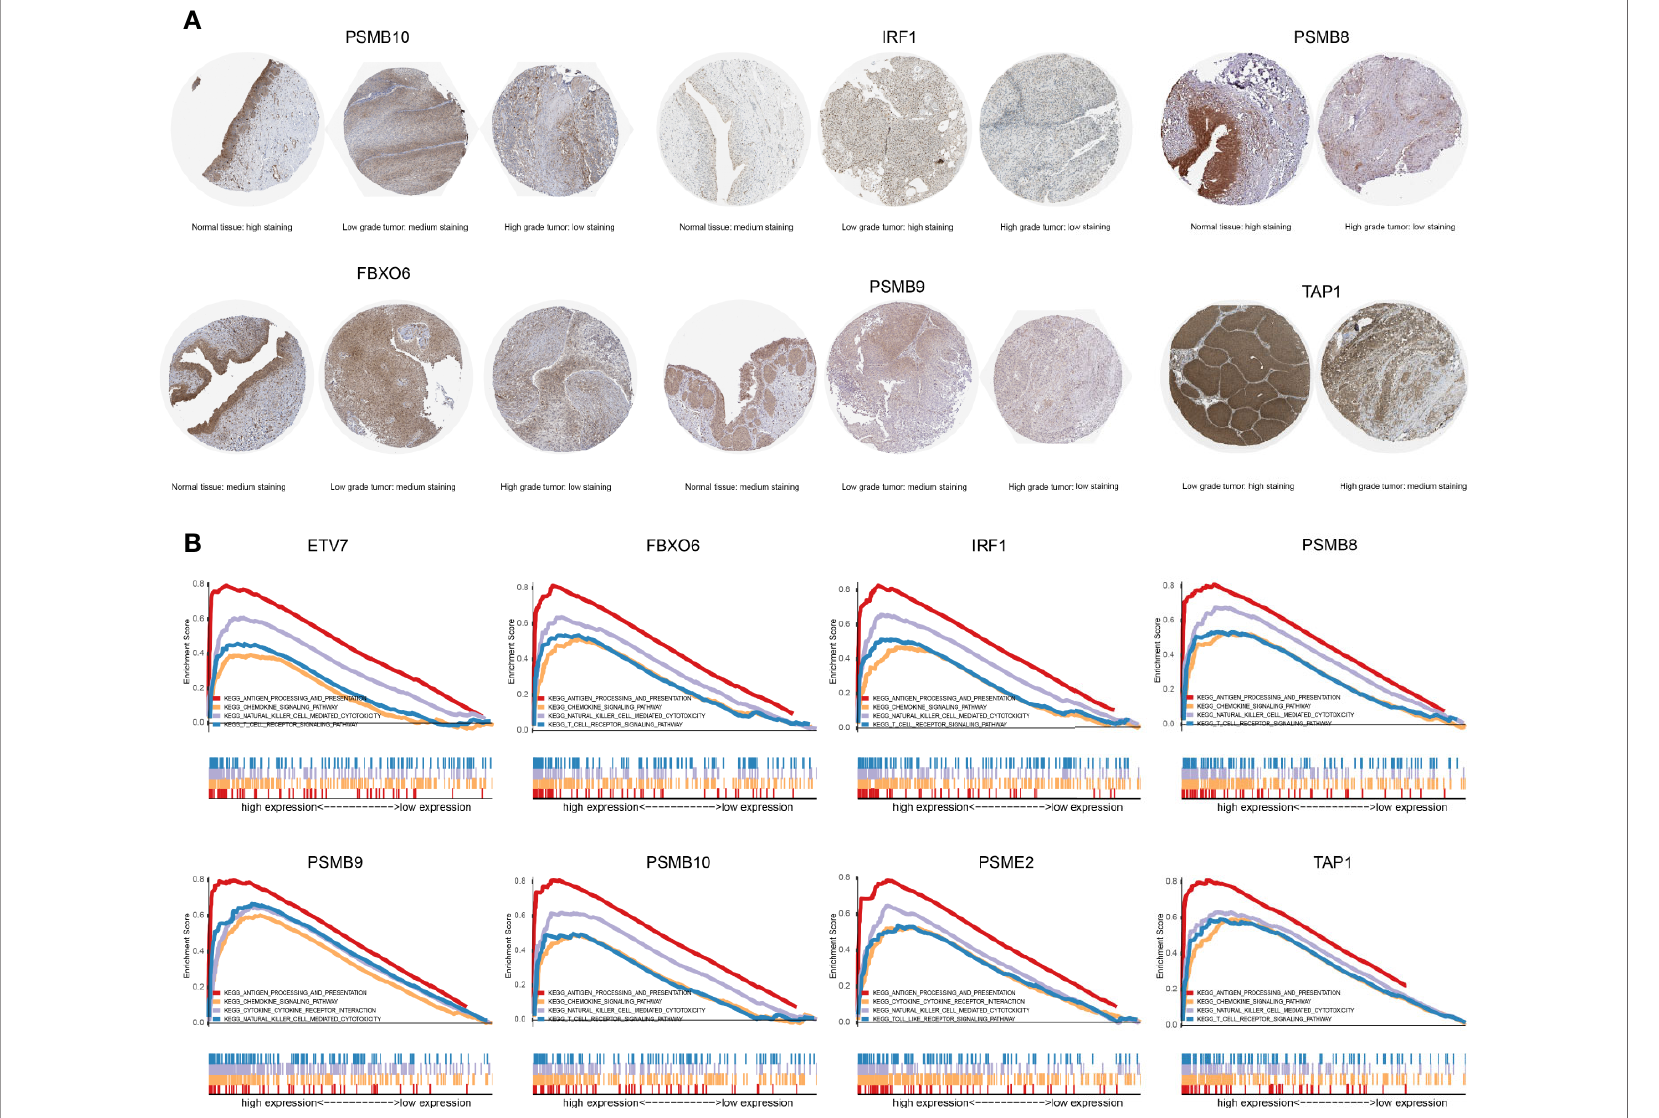
FIGURE 8 | (A) The proteins level encoded by these genes ( PSMB10 , PSMB9 , PSMB8 , TAP1 , IRF1 , and FBXO6 ) were lower in the high clinical grade patients in the human protein atlas (HPA). (B) The results of GSEA analysis. Antigen processing and presentation, the chemokine signaling pathway, nature killer cell-mediated cytotoxicity, and the T cell receptor signaling pathway were related to the high expression group in ETV7 , FBXO6 , IRF1 , PSMB8 , PSMB9 , PSMB10 , PSME2 , and TAP1